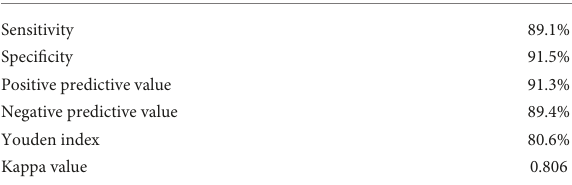
TABLE 2 Diagnostic test characteristics for predicting dysganglionic bowel segment in HSCR patients using a 24-h delayed film of barium